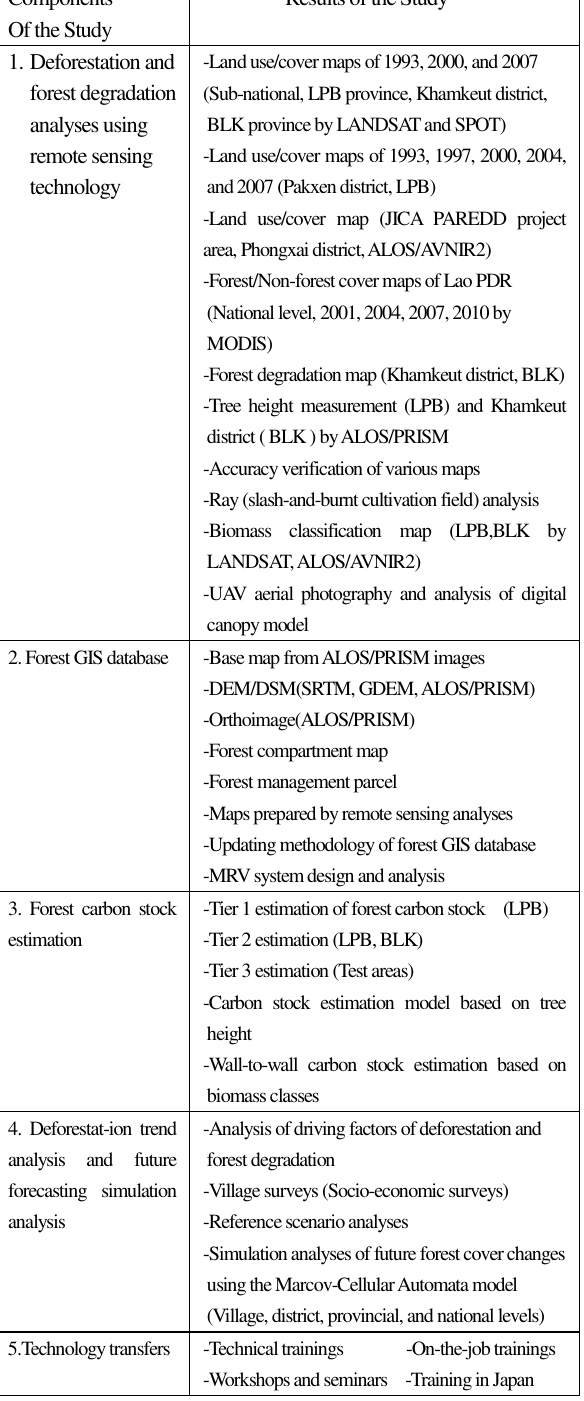
2. PILOT STUDY AREAS